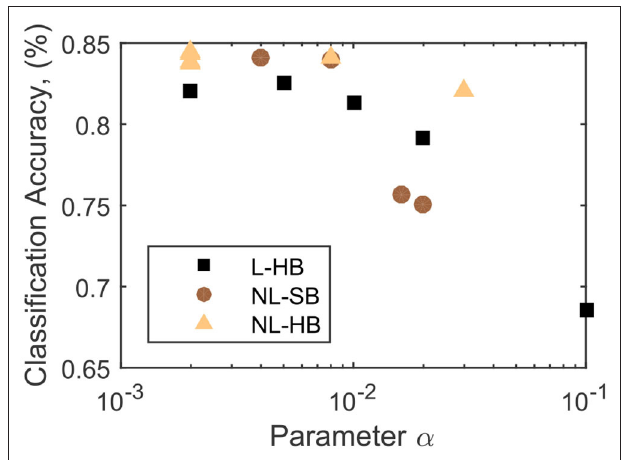
FIGURE 3 | Classification accuracy as a function of the parameter α for the L-HB, NL-SB, and NL-HB